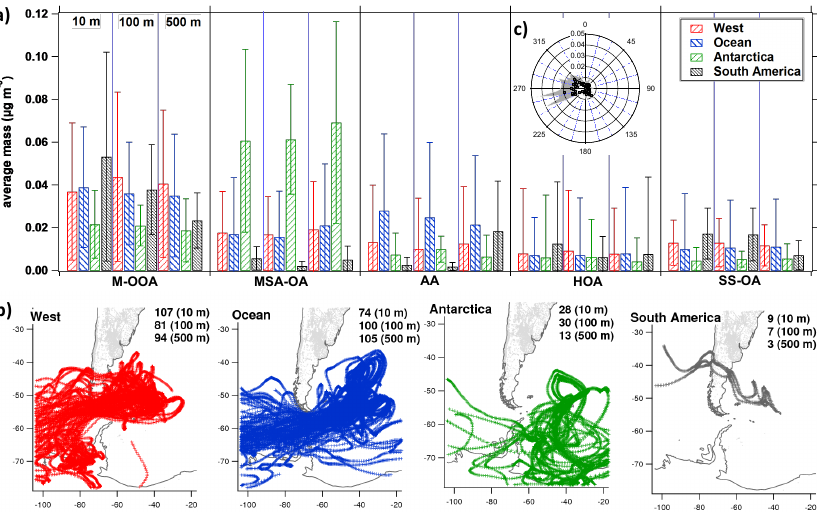
Fig. 7. (a) Average mass concentration and standard deviation for each PMF factor sorted by back trajectory cluster. (b) Example at 100m altitude back trajectory release height for each cluster. The numbers indicate the number of trajectories allocated to the specific cluster with the release heights in parentheses. (c) Wind rose for the PMF HOA factor. The grey shaded area represents the inter-quartiles of HOA concentration in µgm − 3 while the boxes indicate the mean concentration.